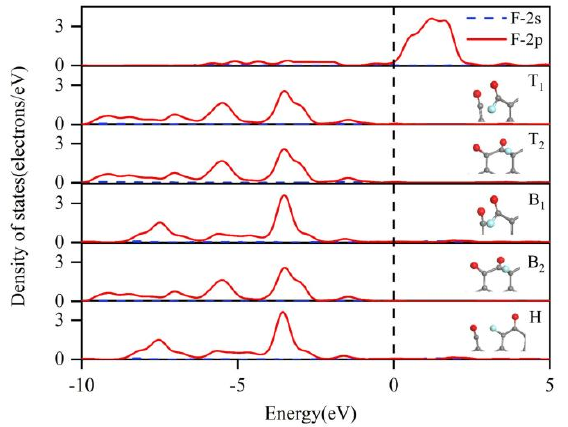
Figure 8. Density of states of F atom adsorbed at different sites on the surface of Model A.